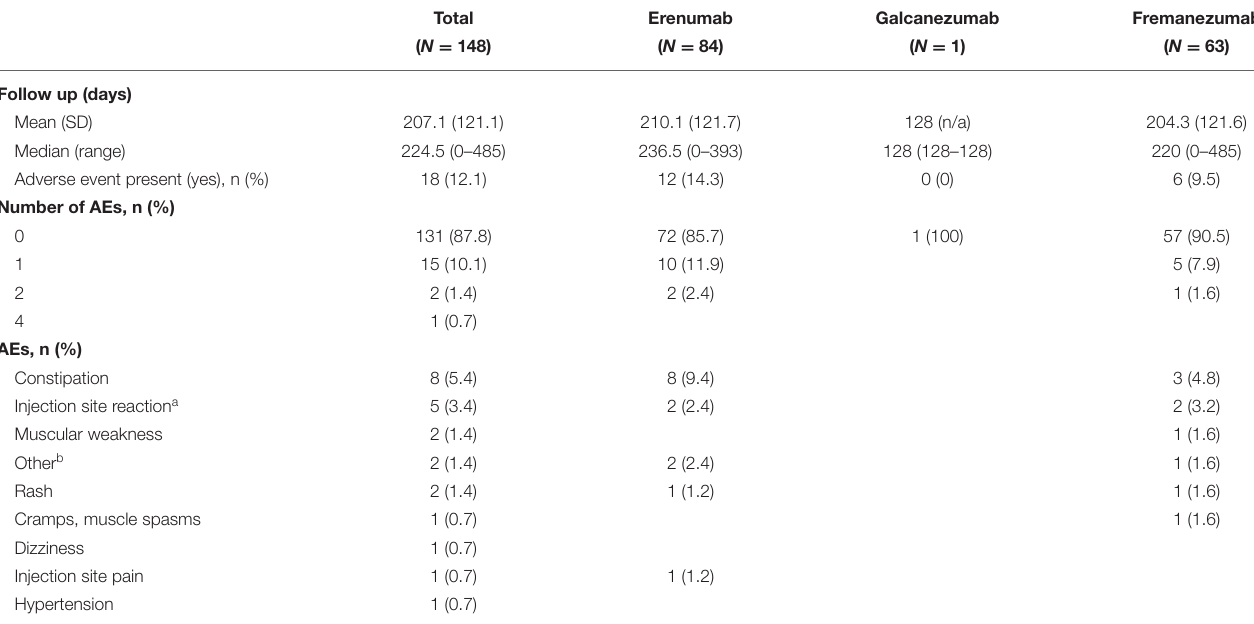
TABLE 5 | Adverse events for the overall study population and stratified by index CGRP mAb